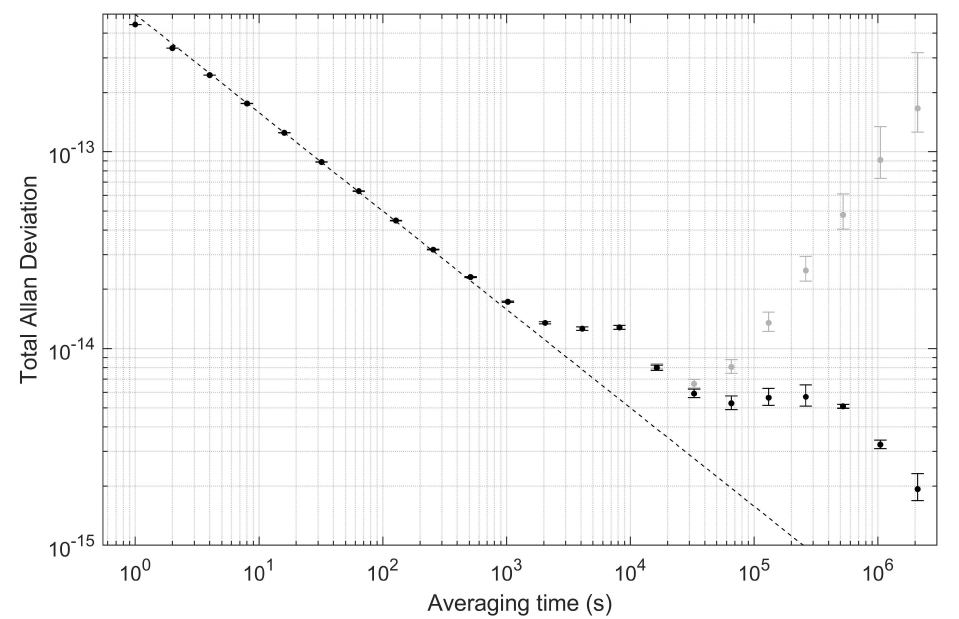
Figure 3. Total Allan Deviation determination of optical clock stability after removing the effect of helium by fitting and subtracting an exponential decay function with linear drift (black markers). Additionally shown in gray markers is the Total Allan deviation of the same data prior to removing the drift. At one day (86,400 s) the fractional frequency deviation is approximately 5 × 10 − 15 . The dashed line corresponds to 5 × 10 − 13 / τ , with τ the averaging time in